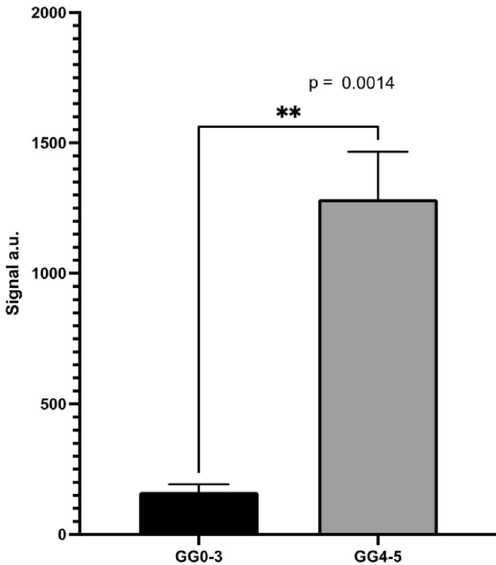
Figure 6. The phage-based assay signal for the potentially lethal and non-lethal PCa. The Y-axis is the linear combination of the measurements (Mean, N = 96, median of 3 replicates, error bars SEM). The left bar shows PCa GG 0–3 (N = 90) samples and the right bar shows GG 4–5 (N = 6). Grade Group for each patient sample was determined by histological analysis of prostate biopsies after MRI and targeted ± systematic